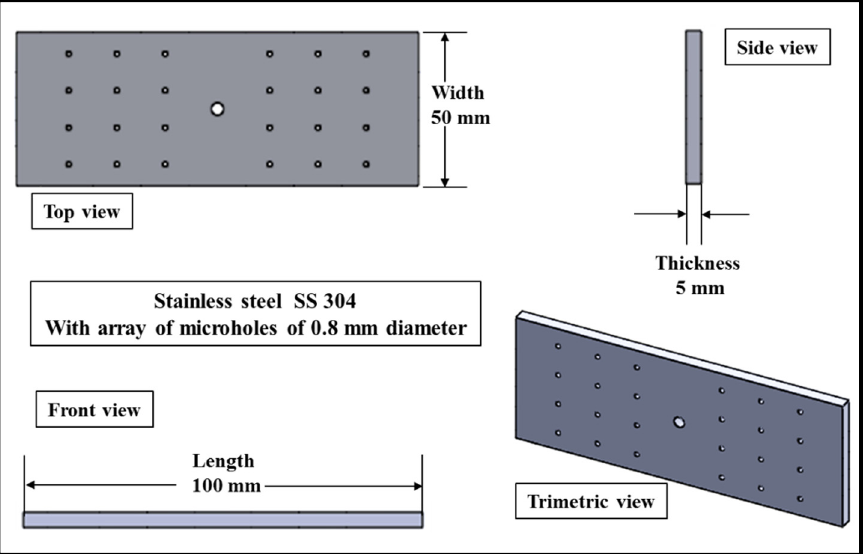
Figure 1. Detail specifications of the rectangular plate used for manufacturing miniature-sized ratchet wheels by WEDM.